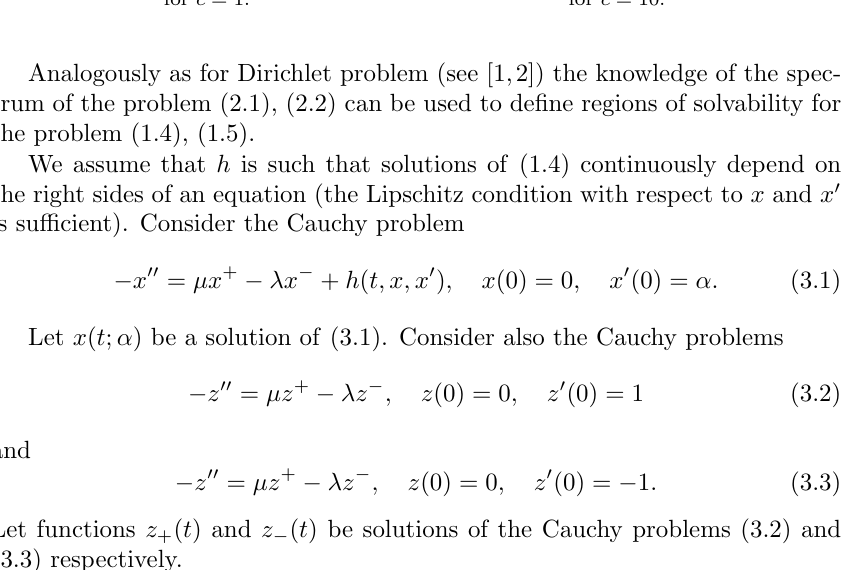
Figure 6. Some spectrum branches for c =